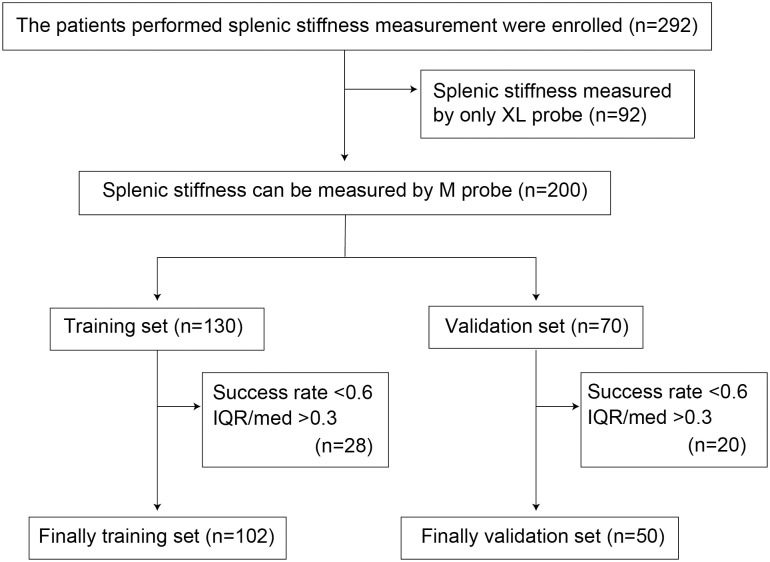
Clinical profiles of patients for the spleen stiffness measurement with and without the new device.IQR = interquartile range.